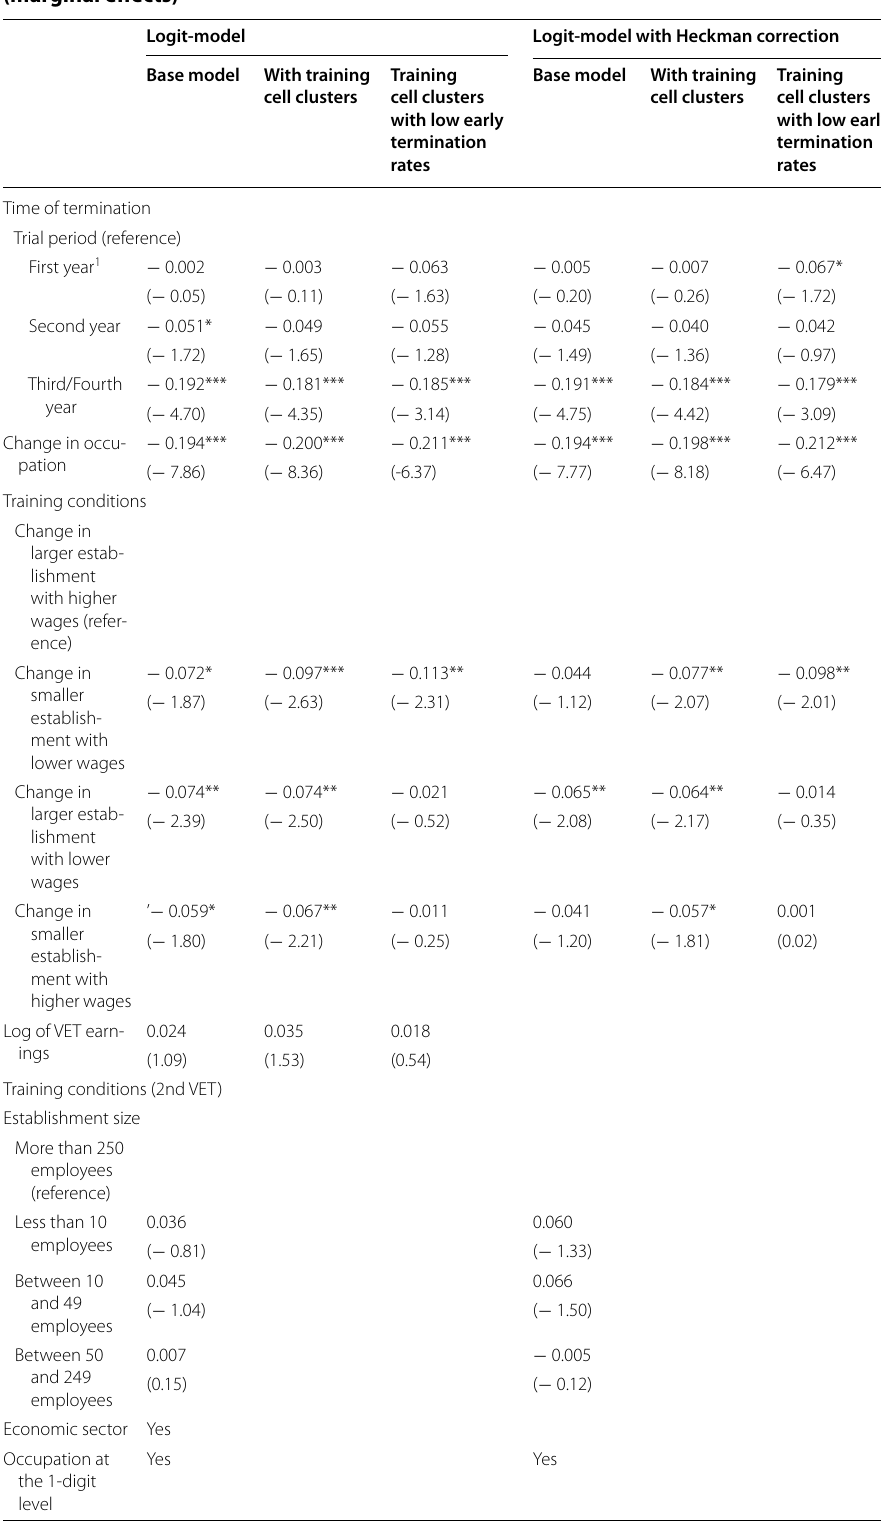
Table 4 Logit model for the probability of succeeding in the second VET programme (marginal